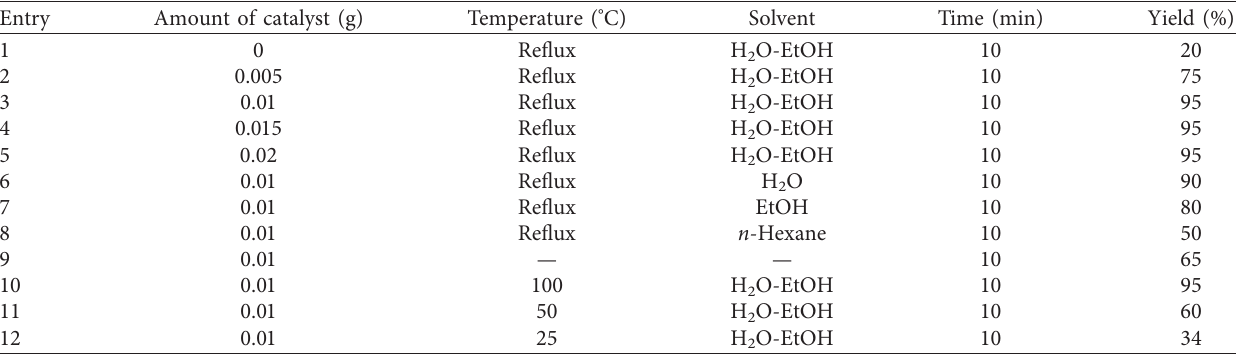
Table 2: Results of screening the